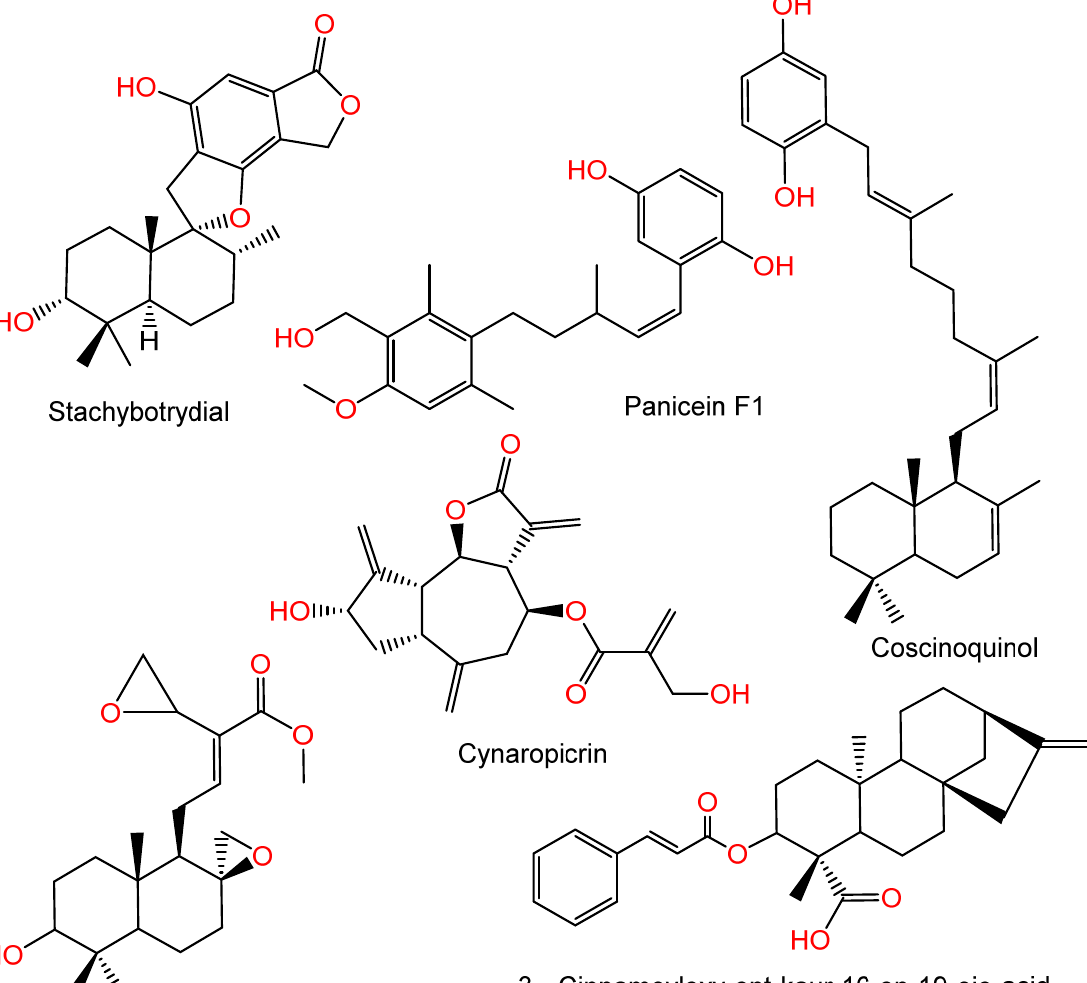
Figure 1. Structures of stachybotrydial, panicein F1, coscinoquinol, cynaropicrin, 3 α -cinnamoyloxy-ent-kaur-16-en-19-oic acid, and aulocarpin.